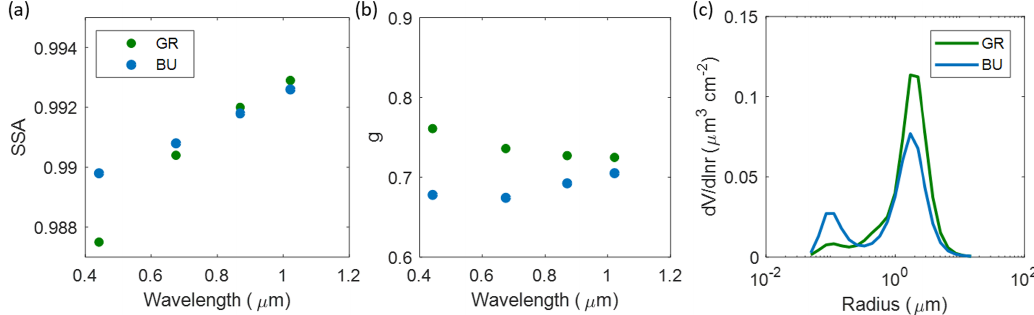
Figure 4. AERONET Level 1.5 retrieved (a) single scattering albedo (SSA), (b) asymmetry factor ( g ) and (c) particle size distribution for the Granada (green) and Bucharest (blue)